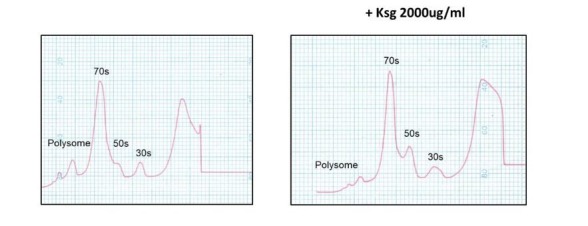
Kasugamycin does not cause formation of 61S mycobacterial ribosomes.Ribosomal profiles of M. smegmatis ribosomes generated by sucrose gradient density centrifugation +/- kasugamycin treatment prior to isolation.